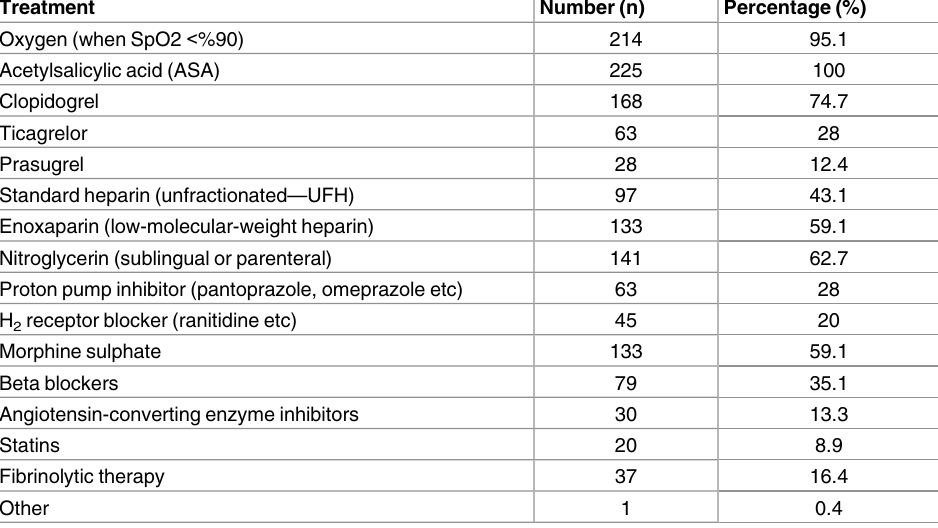
Table 1. Treatments administered by emergency specialists for STEMI patients in emergency